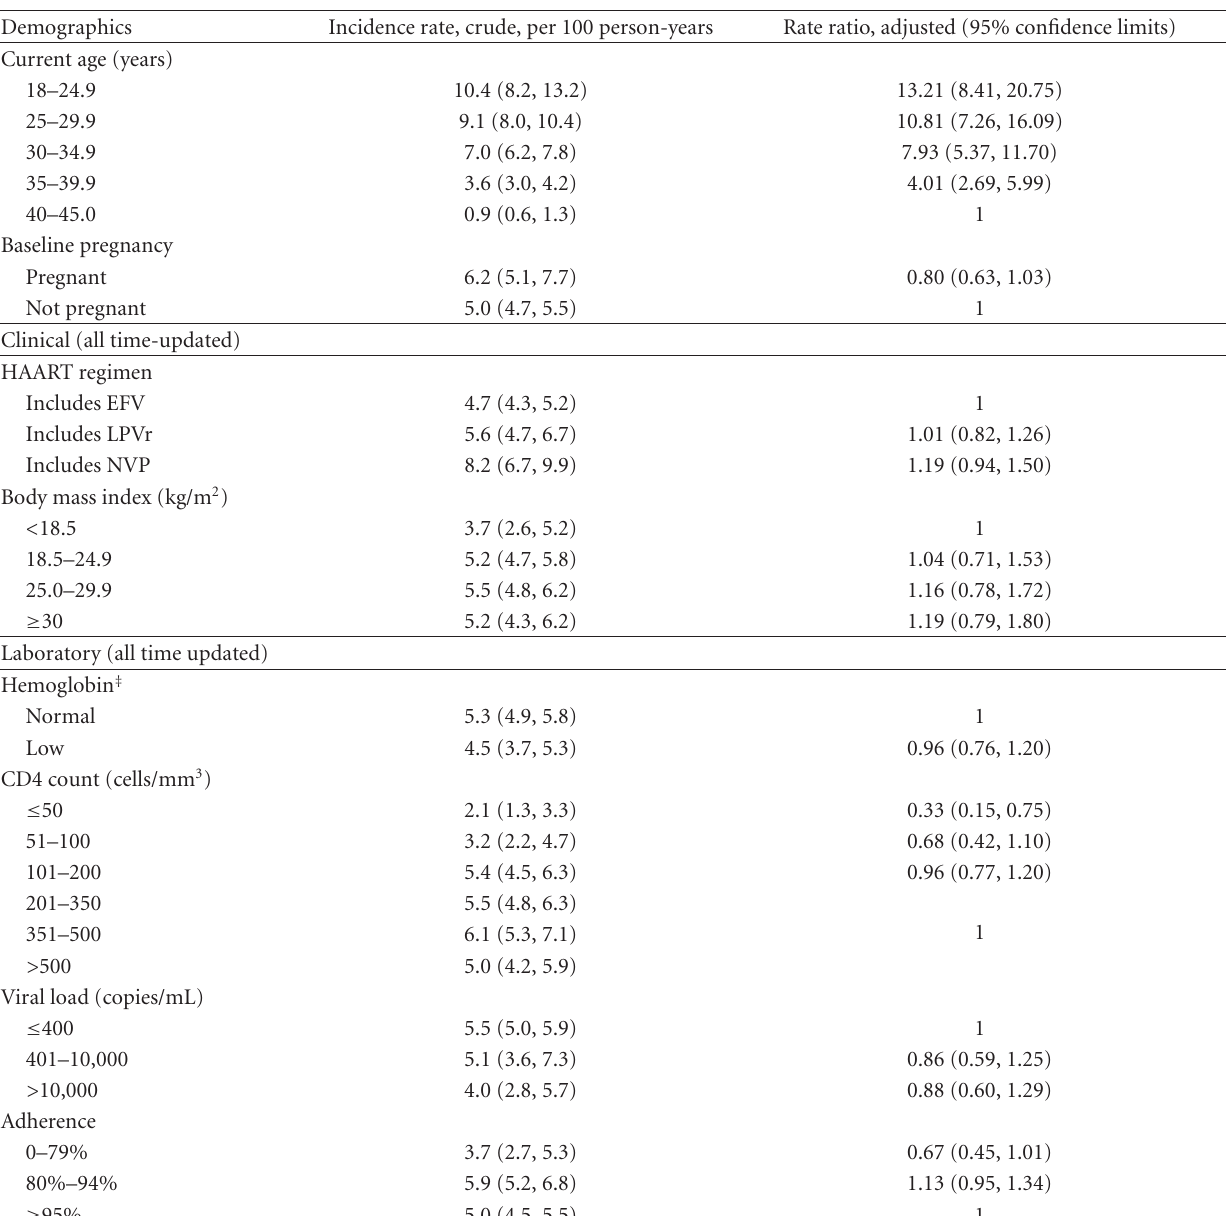
Table 2: Incident rate and adjusted incident rate ratio for association of demographic, clinical, and laboratory indicators with